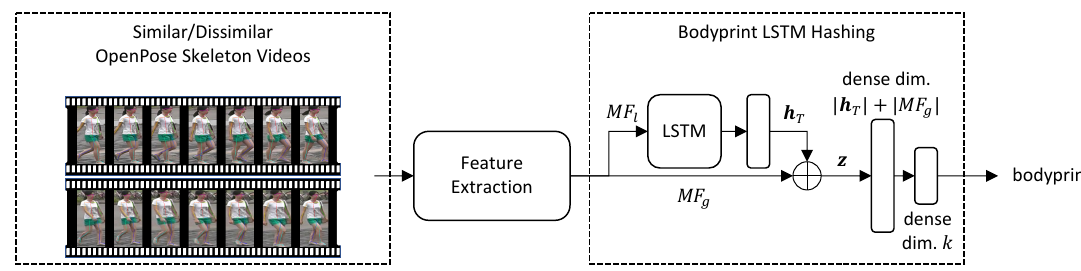
Figure 1. Long short term memory (LSTM) bodyprint hashing architecture